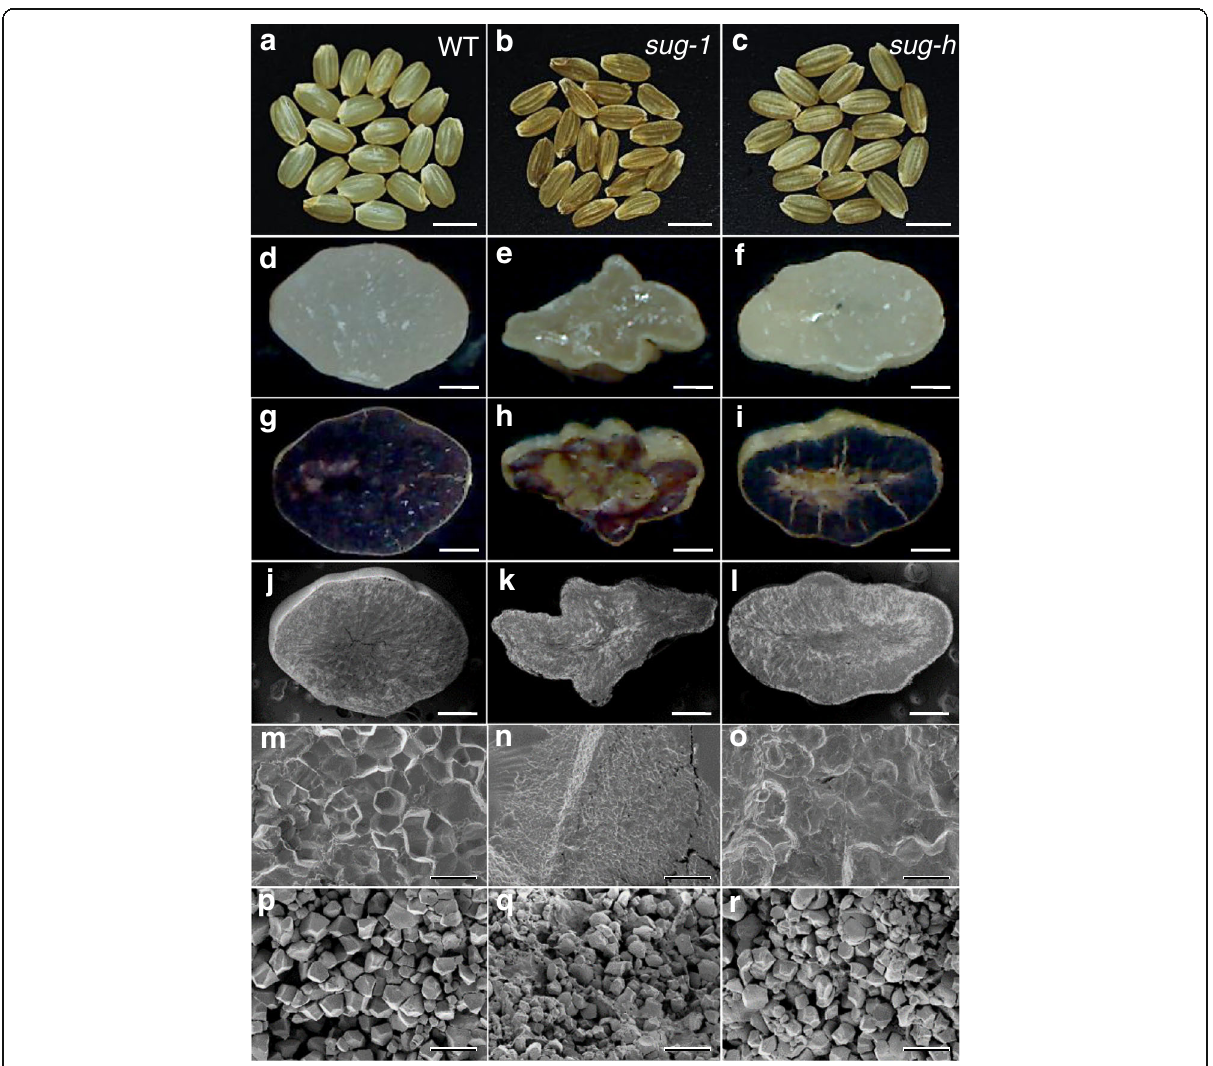
Fig. 1 Optical and scanning electron microscopy observation of grain phenotype and starch granule structure. a - c The sug-h mutant grain exhibits a phenotype that is intermediate between that of the wild type and sug-1 . Bars = 4 mm. d - i Cross sections of wild-type, sug-1 , and sug-h kernels at the mature stage. Sectioned seeds were stained with iodine solution. Bars = 0.5 mm. j - o SEM observations of wild-type, sug-1 , and sug-h mutant endosperm. j - l Bars = 0.5 mm. (m-o) Bars = 10 μ m. p - r SEM observations of starch granule structures in wild-type, sug-1 , and sug-h mutant endosperm. Bars = 10 μ